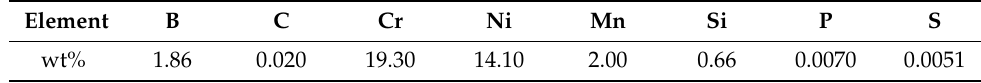
Table 1. Chemical composition of investigated alloys in wt%.